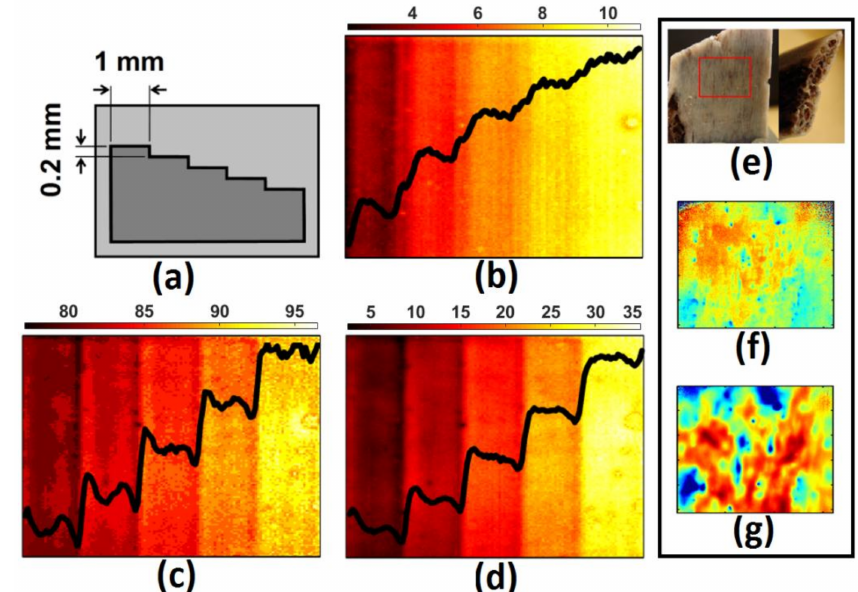
Figure 9. ( a ) cross section of step wedge light-absorbing inclusion in a turbid medium; ( b ) conventional lock-in thermography (LIT) phase (unit: degree); ( c ) BPC peak delay time (unit: millisecond); and ( d ) BPC phase images (unit: degree) of the step wedge sample using thermal coherence tomography (TCT) (16-bit code). The curve in each image shows the mean horizontal profile of the corresponding contrast parameter; ( e ) pictures of the interrogated surface and cross section of a goat bone; TCT phase images of goat bone at ( f ) 10 Hz and ( g ) 1 Hz carrier frequencies